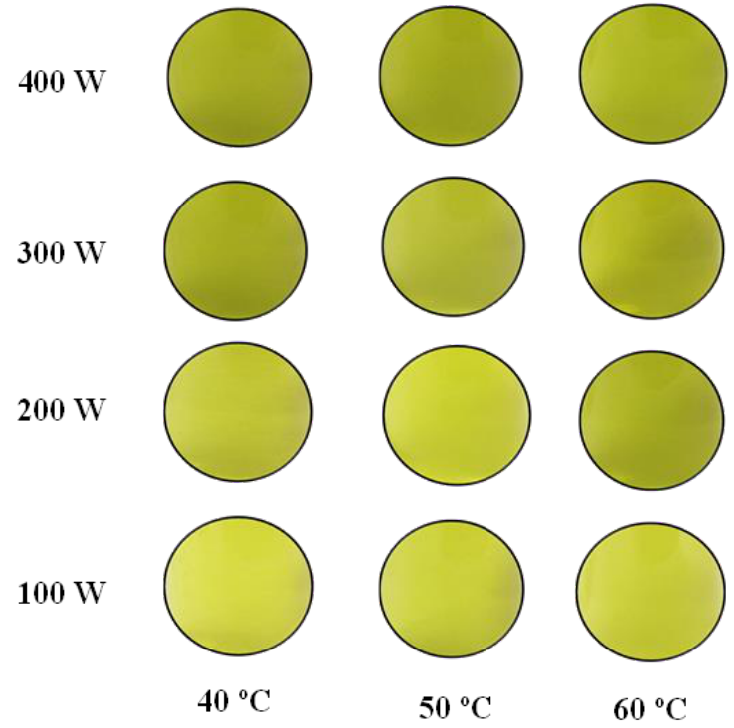
Figure 2. Thermosonication effects on the visual appearance of the fennel extracts.